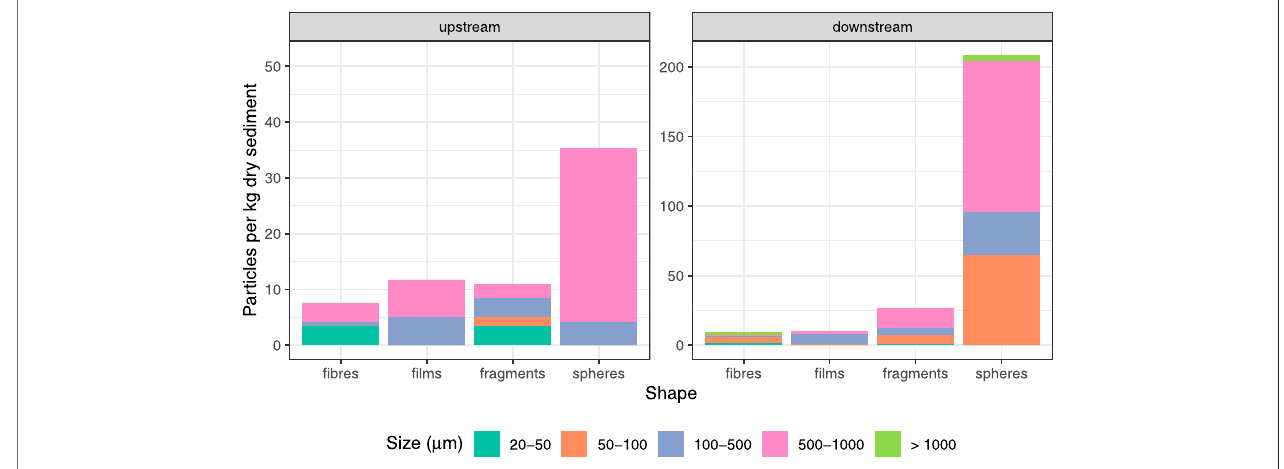
FIGURE 2 | Number of presumable microplastics in sediment samples by shape. Note different scales in the ratio 1:4 on the y axis.